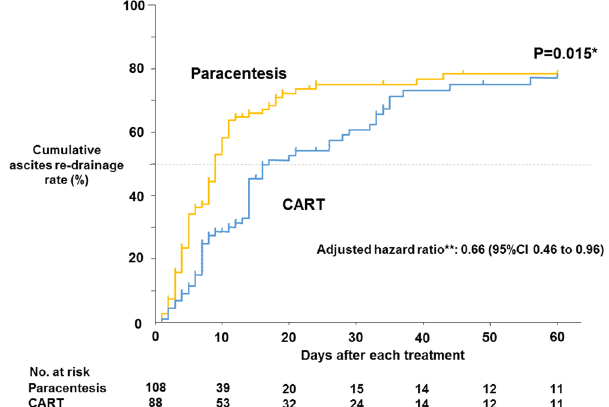
Figure 3. Kaplan-Meier comparison of ascites re-drainage rate within 60 days after drainage treatment. * Ascites re-drainage rate within 60 days after treatment was compared between the 2 groups by the log-rank